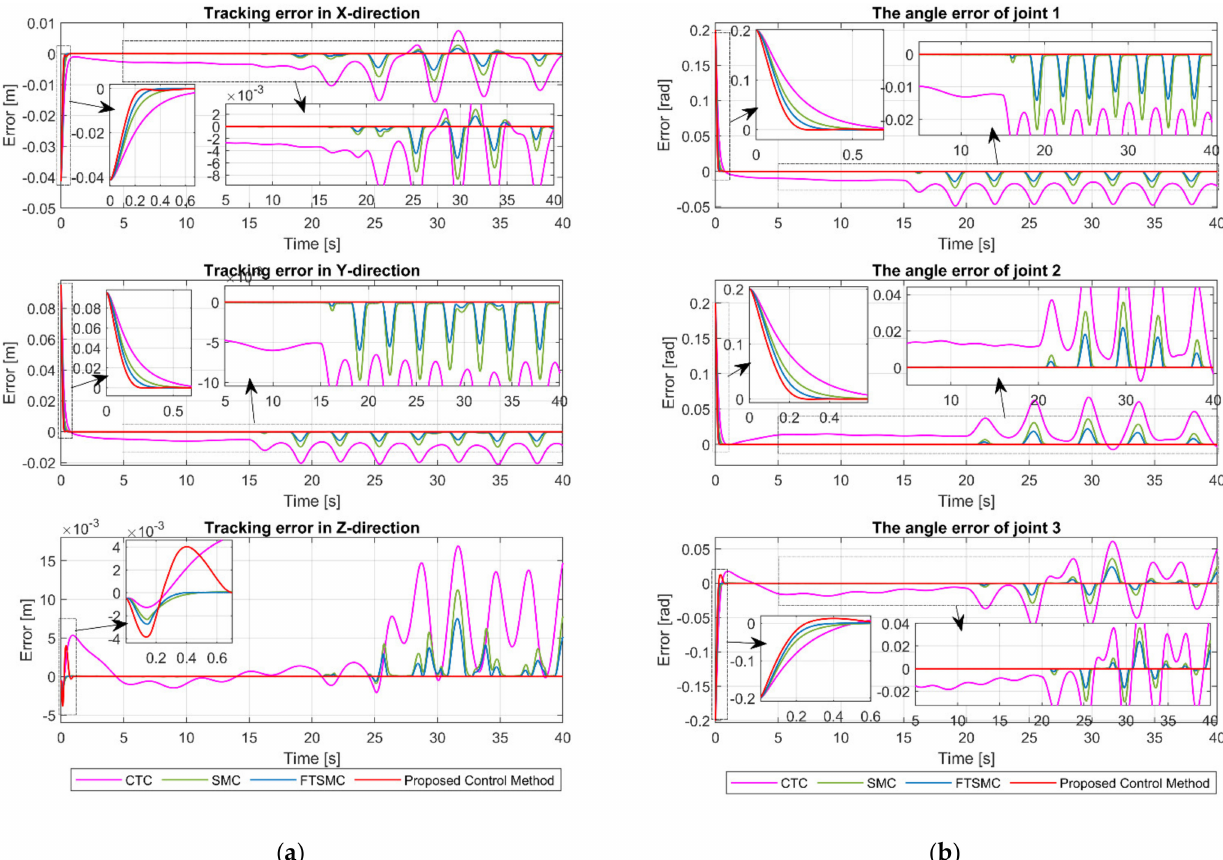
Figure 10. ( a ) The tracking errors of end-effector in X, Y, and Z direction.; ( b ) The tracking errors of joint 1, joint 2, and joint